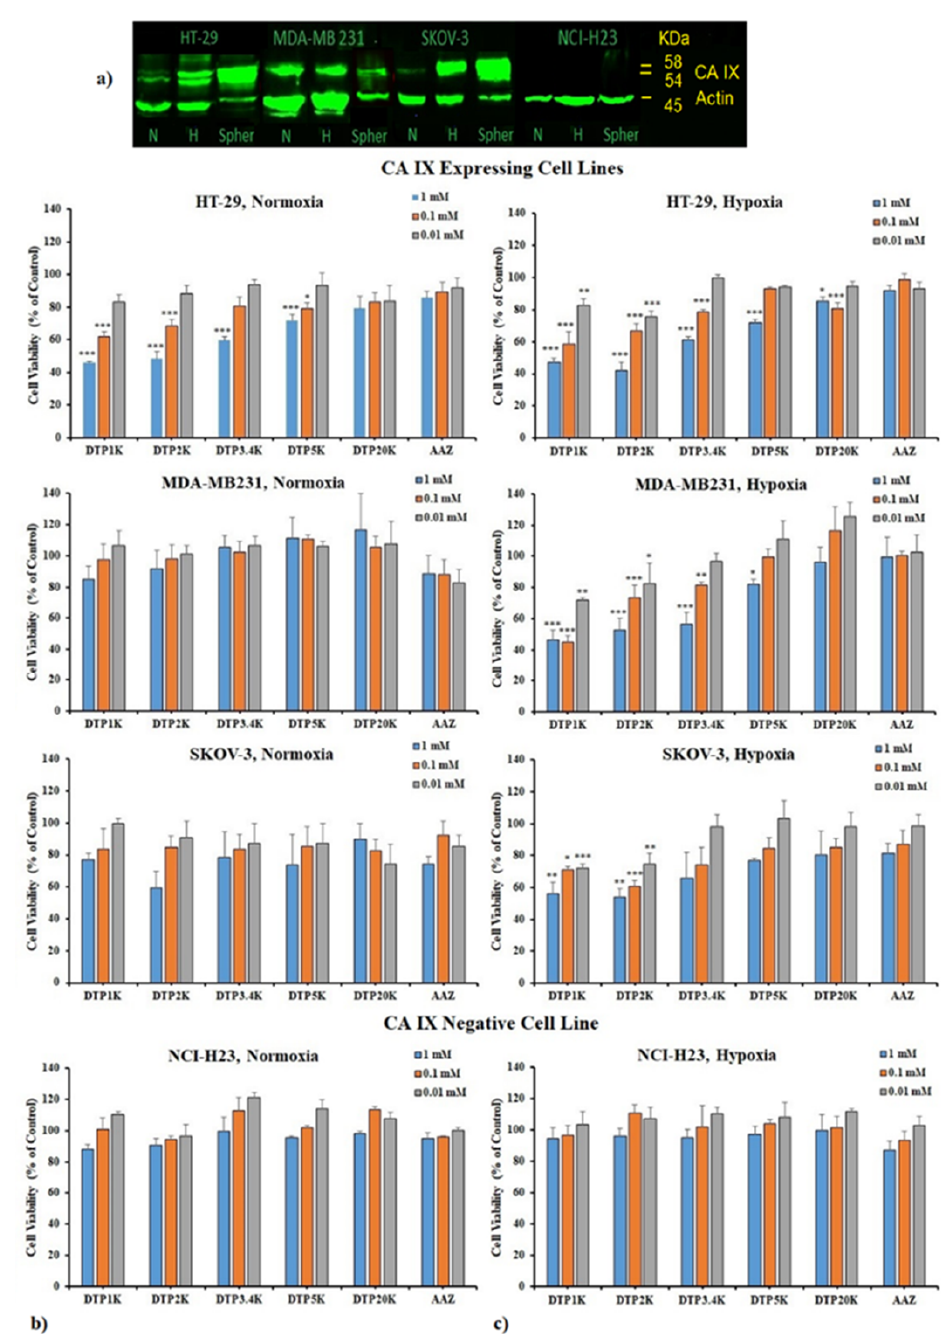
Figure 3. ( a ) Expression of CA IX target in 2D (normoxic/hypoxic) and 3D cancer cell cultures and the effect of PEGylated CAIs DTP2K 23 and DTP1K 28–DTP20K 31 and acetazolamide AAZ 1 at different concentrations on the viability of CA IX expressing cell lines (HT-29, MDA-MB231, and SKOV-3) and CA IX-negative cell line (NCI-H23) under normoxic ( b ) and hypoxic ( c ) conditions (all 2D cell cultures): the p values were determined by one-way ANOVA, comparing the value